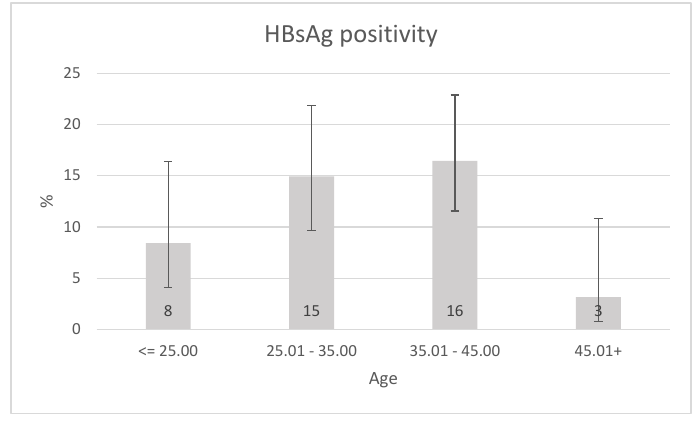
Figure 2. HBsAg positivity prevalence according to age, error bars represent 95% CI, p for trend 0.047. Table 4. A comparison of imprisonment, drug use, blood transfusion, sexual behavior and tattoo procedure between HBsAg-positive and -negative Roma people. Multivariate Analysis n HBsAg Positive HBsAg Negative p OR and Significance